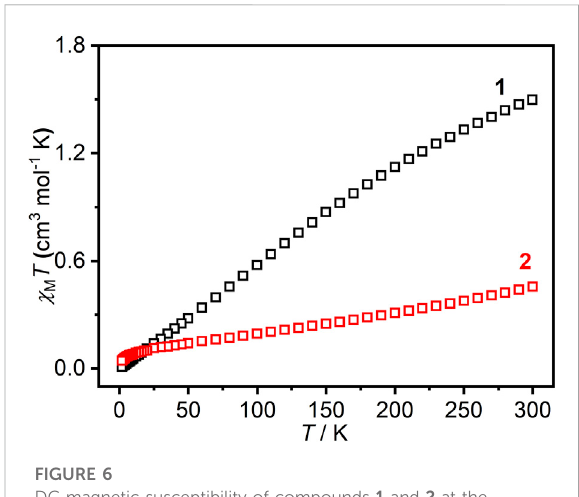
FIGURE 6 DC magnetic susceptibility of compounds 1 and 2 at the temperature range of 3 – 300 K and the magnetic fi eld of 1.0